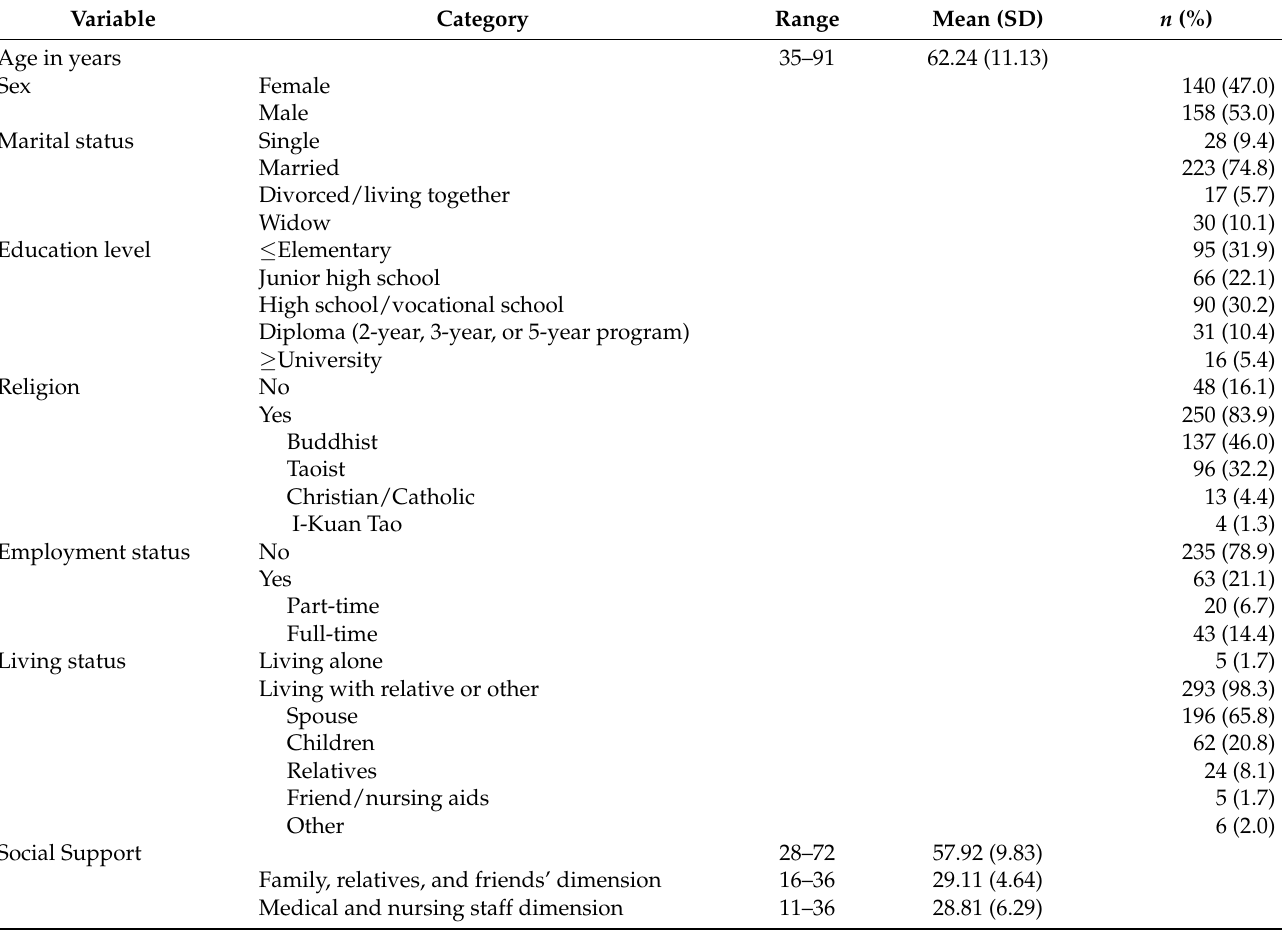
Table 1. Sociodemographics of hemodialysis patients ( n =